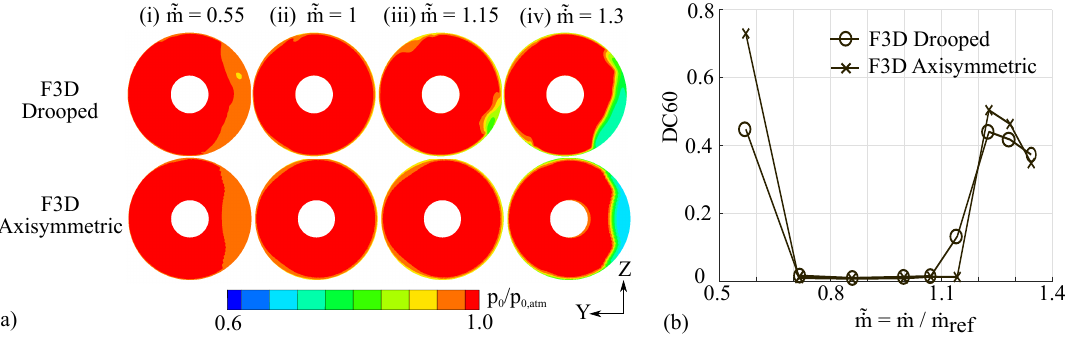
Figure 6. Drooped and axisymmetric cases: comparison of ( a ) P 0 and ( b ) DC60 at fan